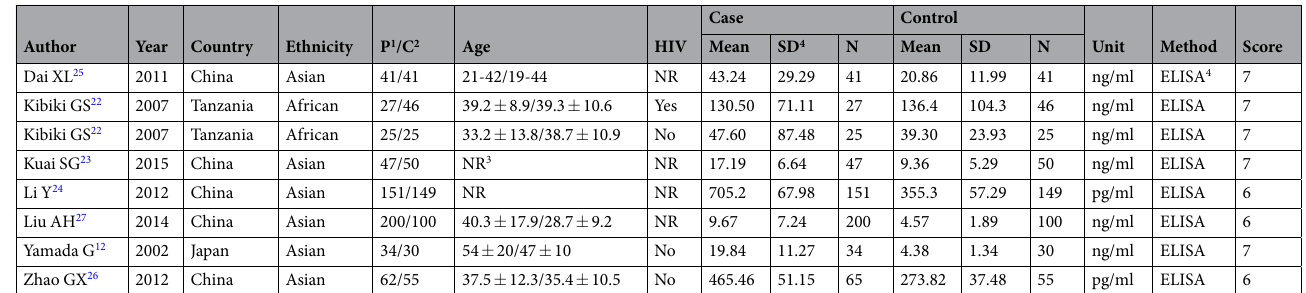
Table 2. Characteristics of the studies involving the association between the serum MIF levels and PTB included in the meta-analysis. 1 patient; 2 control; 3 not reported; and 4 enzyme-linked immunosorbent assay.